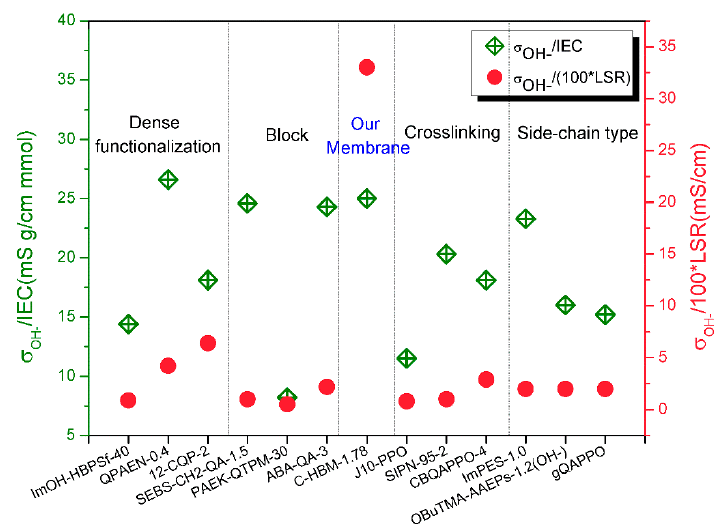
Figure 6. Comparison regarding effective hydroxide conductivity ( σ OH- /IEC, σ OH- /LSR) of our membrane C-HBM-1.78 with reported densely functionalized, block, crosslinked, and side-chain-type membranes.